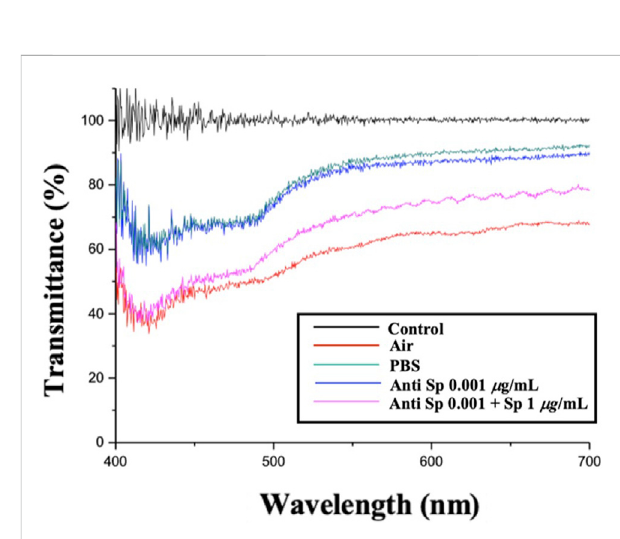
FIGURE 4 Spike protein in cholesterol liquid crystal chip detection by penetration spectroscopy.